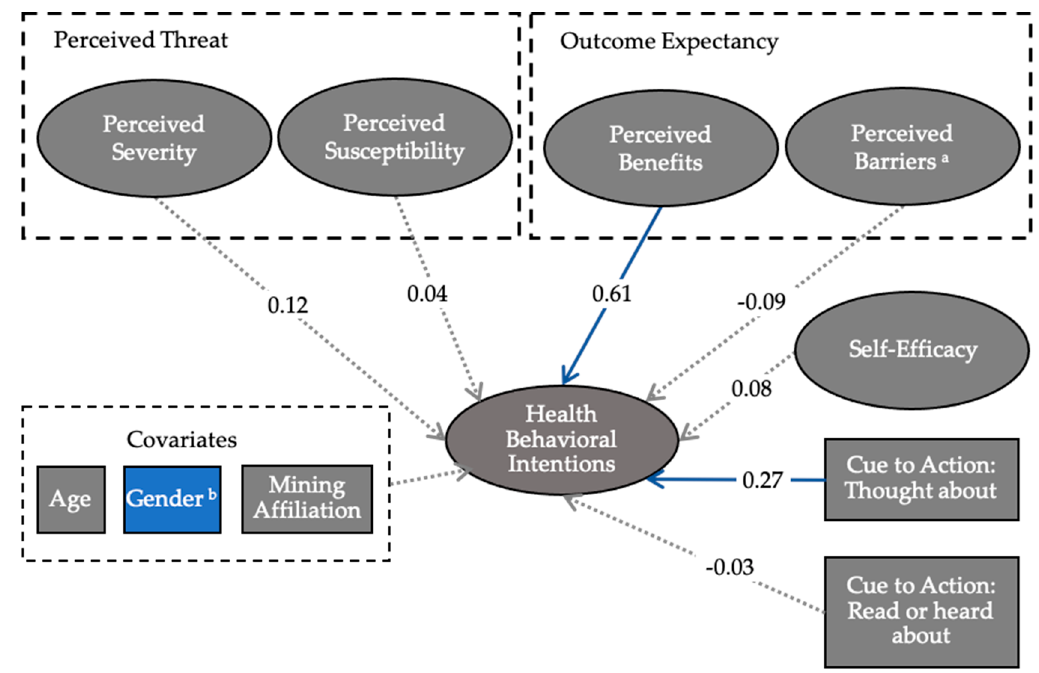
a Perceived barriers